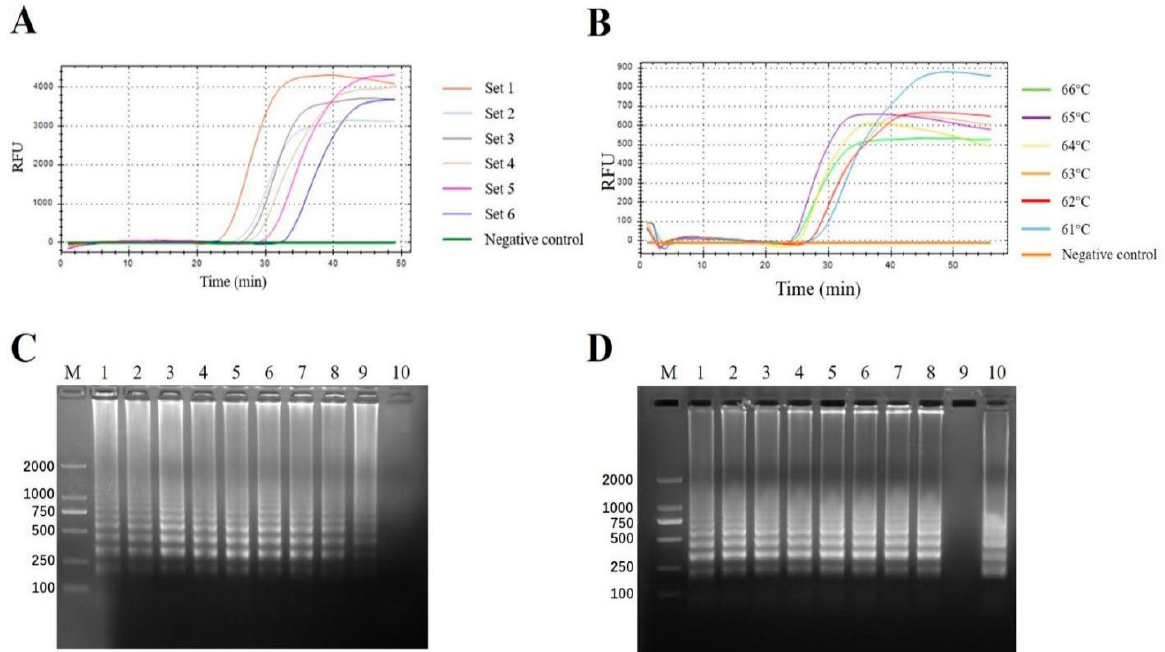
Figure 1. The selection of the optimal reaction conditions of the visual RT ‐ LAMP assay. ( A ) The selection of the visual RT ‐ LAMP primer sets measured by the fluorescent curves. Totally 6 sets of candidate LAMP primers were tested. Different primer sets were represented in different colors. ( B )